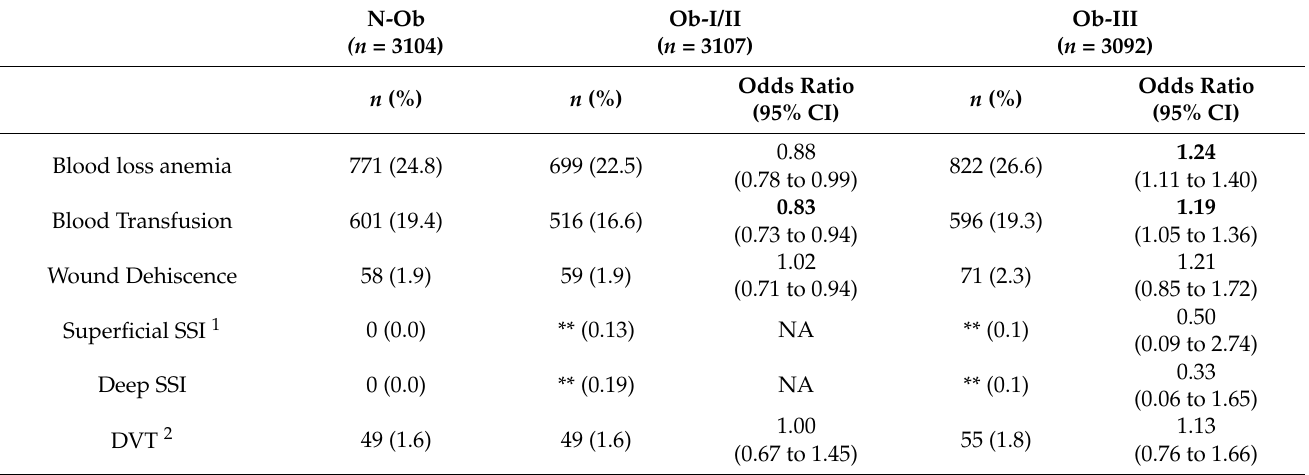
Table 2. Morbidity and mortality of N-Ob, Ob-I/II, and Ob-III patients undergoing below-the-knee amputations. The average total cost per patient per hospitalization is also included. The odds ratio has been adjusted for age, sex, diabetes, tobacco use, and emergency versus elective